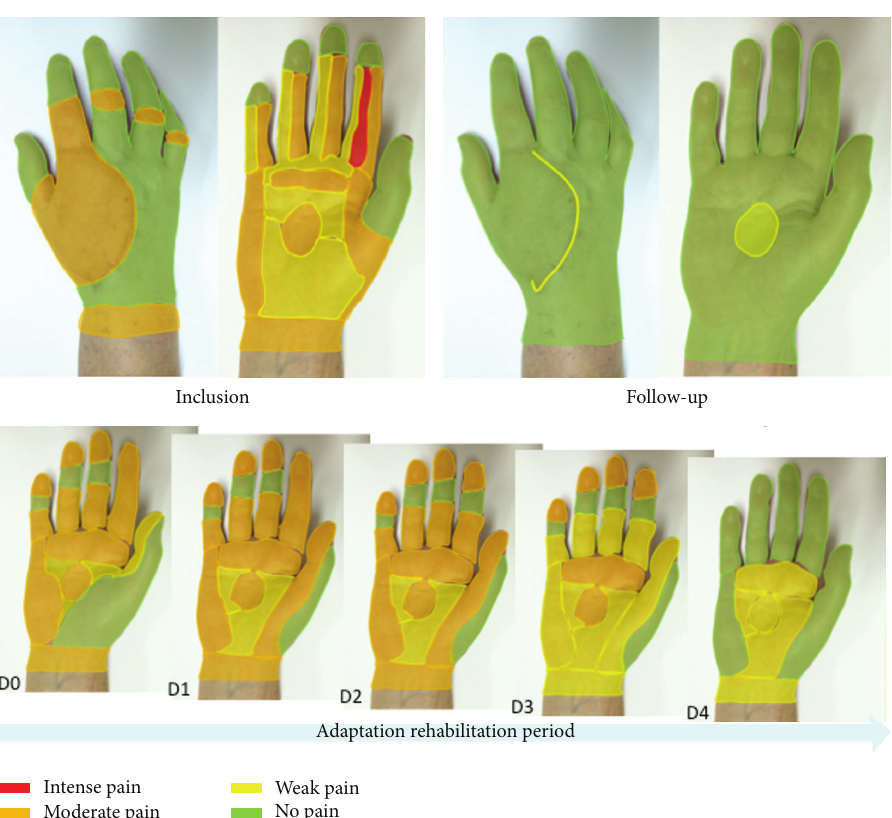
Figure 7: Visual representation of pain evolution for one patient. This patient developed CRPS following a trauma in a car accident with no fracture but some tissue lost on her hand back for which she had a skin graft. The initial mapping of pain (inclusion) was surprisingly nonmonotonous,withidiopathicdesignofpainintensityareas,andpredominantlyinvolvedthepalmeventhoughthissidewasnotconcerned by surgery. The evolution of pain evaluation is depicted from the first (D0) to the last (D4) day of the intervention. A demonstrative reduction of surface and intensity of pain was observed over all hand territories. This pain mapping in space and time allows observing that the most painful territories do not recover last and that there is no clear anatomofunctional rationale for the shape and size of individual areas or for their temporal evolution. At the follow-up consultation, a nearly normalized mapping was produced by the patient, except for a tiny area in the palm and a portion of the hand back side’s